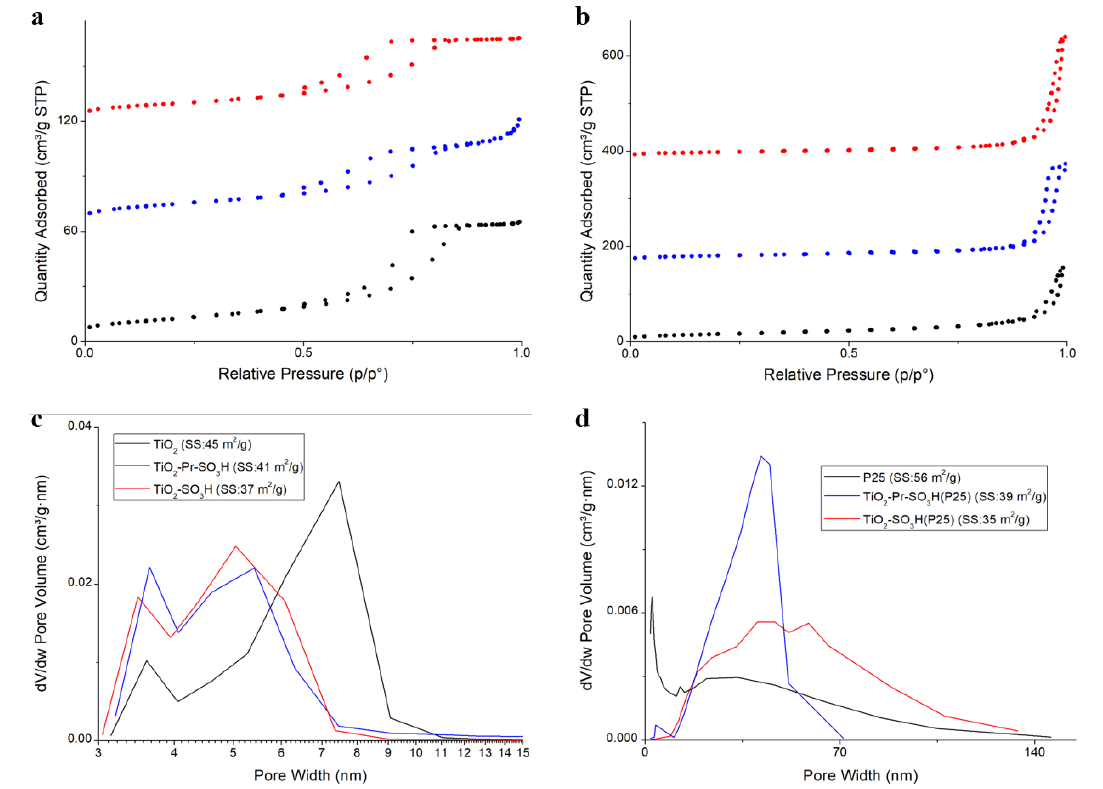
Figure 5. ( a , b ) Nitrogen adsorption – desorption isotherms (for sake of clarity the curves are shifted up their y axes), and ( c , d ) pore distribution of bare TiO 2 and its derivatives.